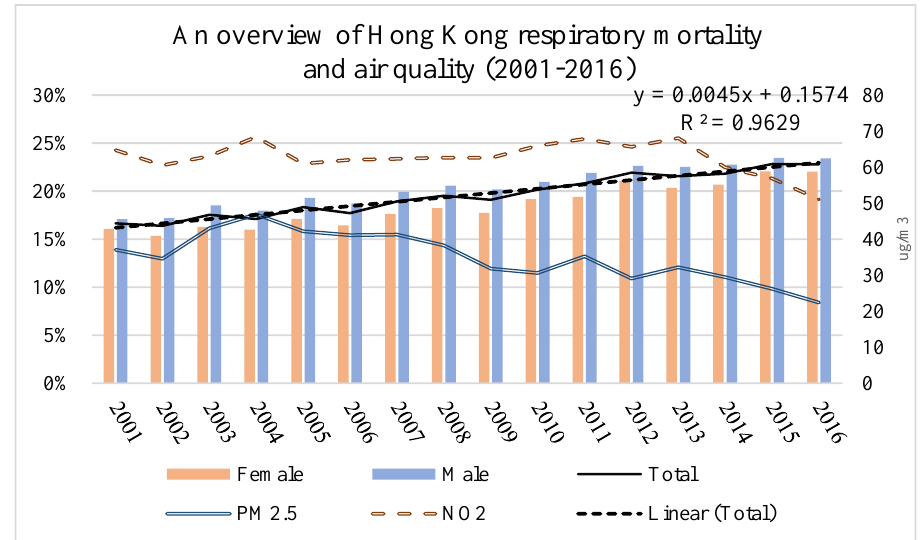
Figure 2. An overview of Hong Kong respiratory mortality and air quality (2001 – 2016). (The respiratory mortality rate was 16.65% in 2001, and it increased to 22.79% in 2016. The male mortality rate was generally higher than the female rate. The PM2.5 and NO2 showed a slight decrease from 2001 to 2016).